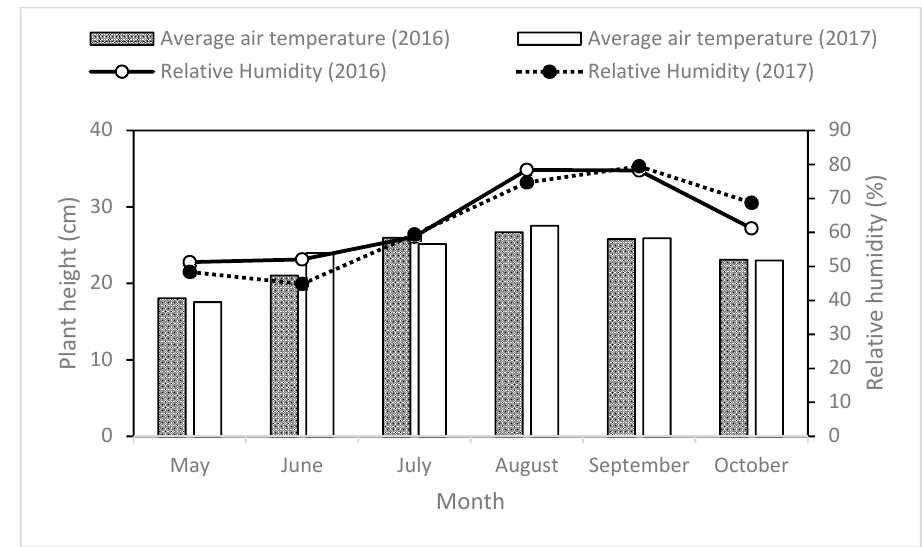
Figure 1. Monthly average air temperature and relative humidity in the 2016 and 2017 growing seasons.